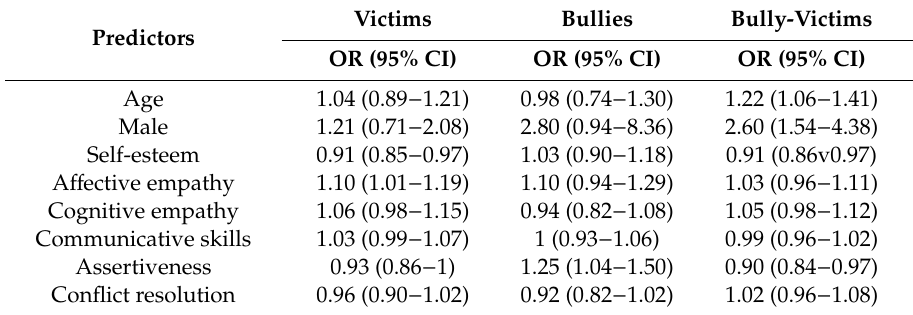
Table 3. Multinomial regression with age, gender, self-esteem, empathy, and social skills as predictors of di ff erent bullying roles.